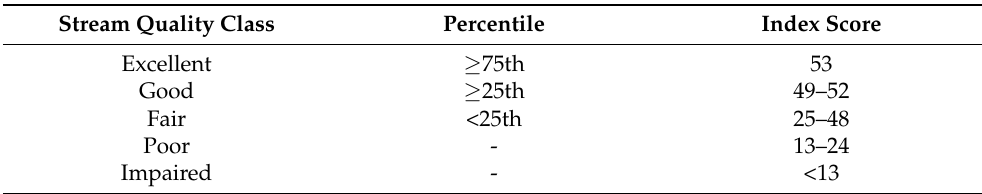
Table 7. Proposed water quality classes and index score for the studied wadeable rivers and streams in Lao